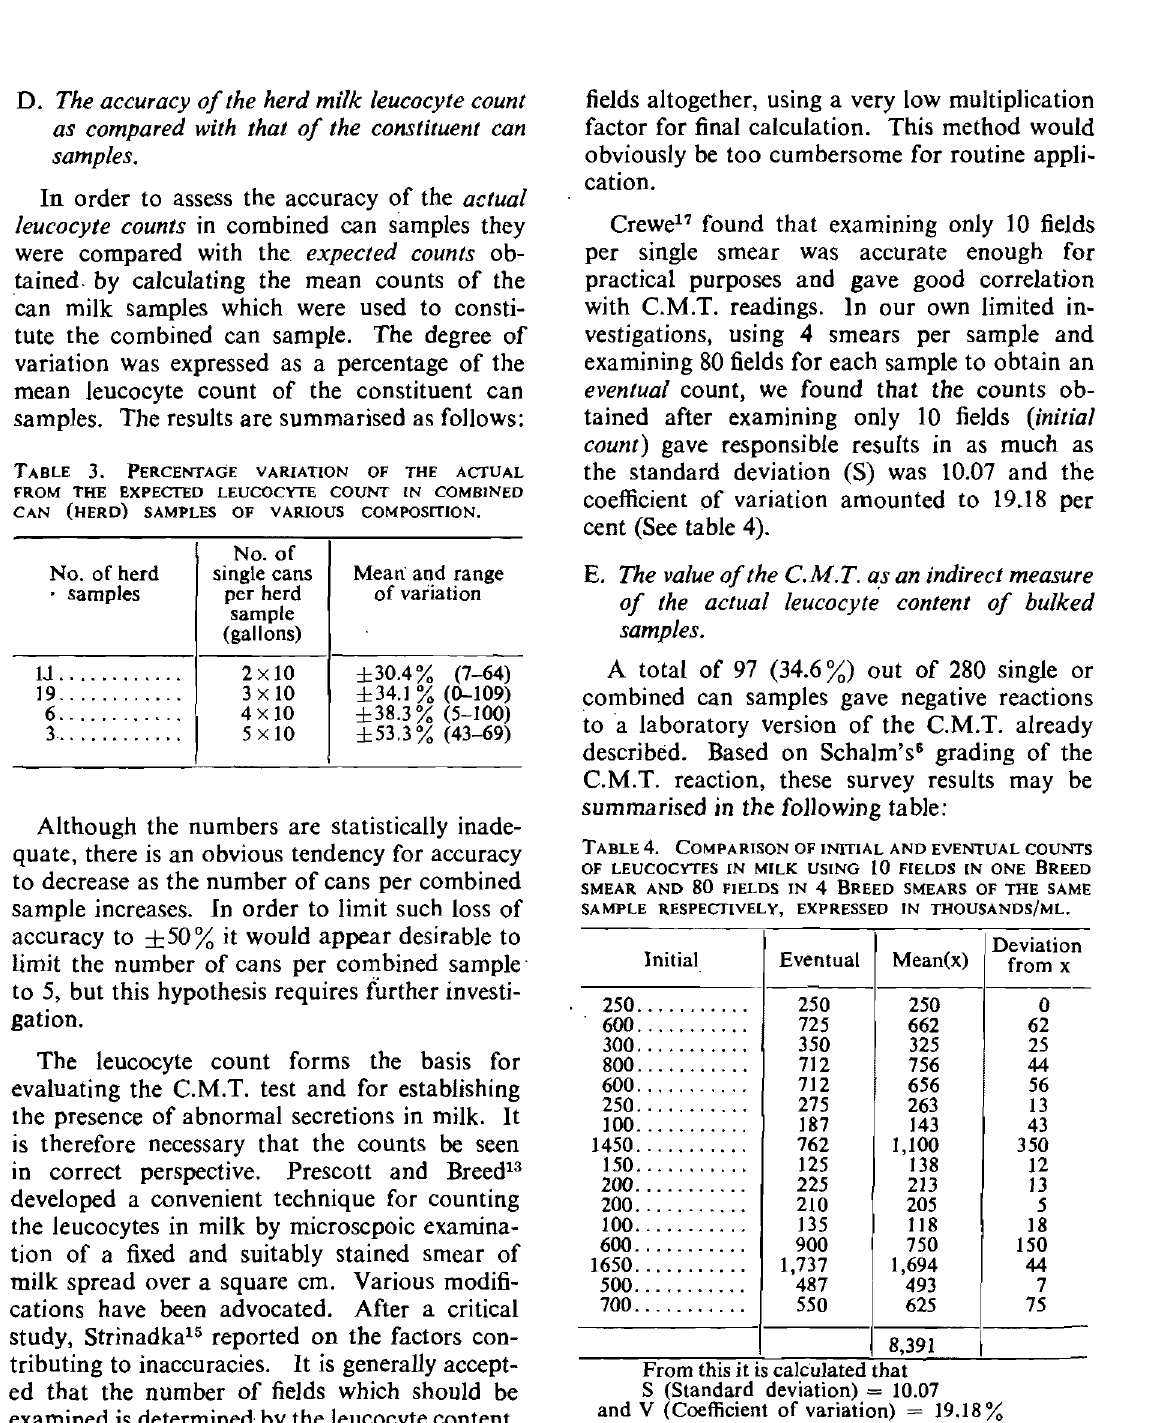
TABLE 3. PERCENTAGE VARIATION OF THE ACTUAL FROM THE EXPECTED LEUCOCYTE COUNT IN COMBINED CAN (HERD) SAMPLES OF VARIOUS COMPOSITION.